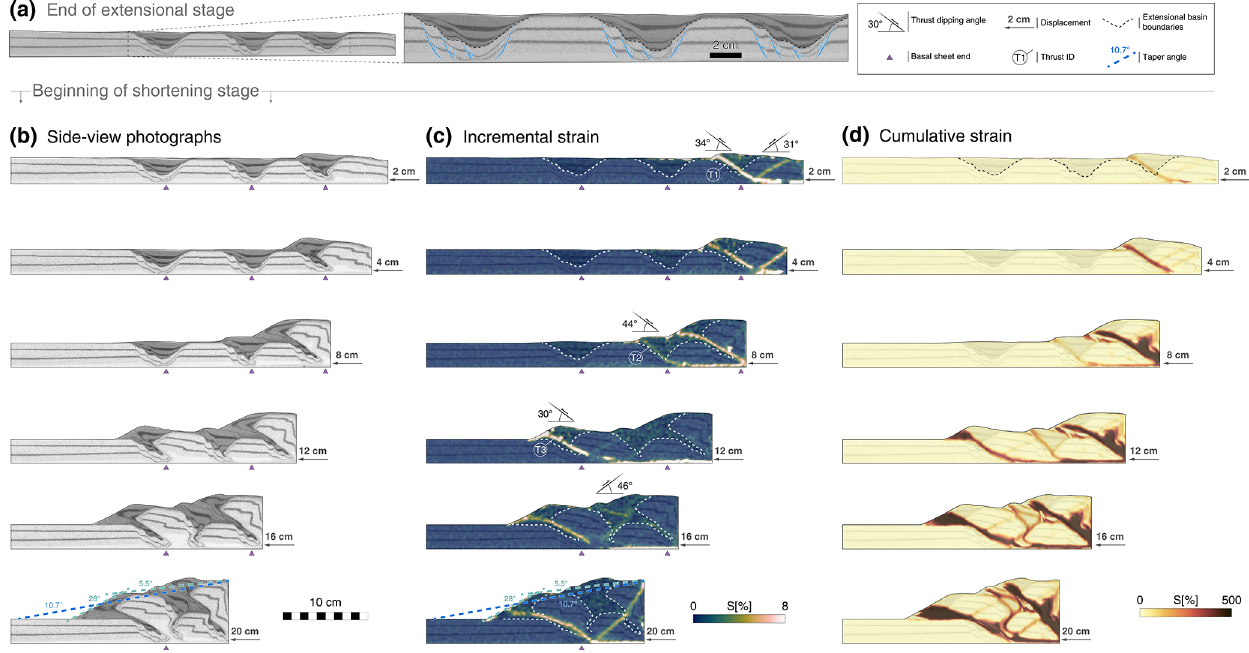
Figure 7. Experiment 3B summary. (a) Side-view photograph and interpreted close-up view at the end of the extensional stage. Shortening stage evolution, showing (b) side-view photographs, (c) incremental strain, and (d) cumulative